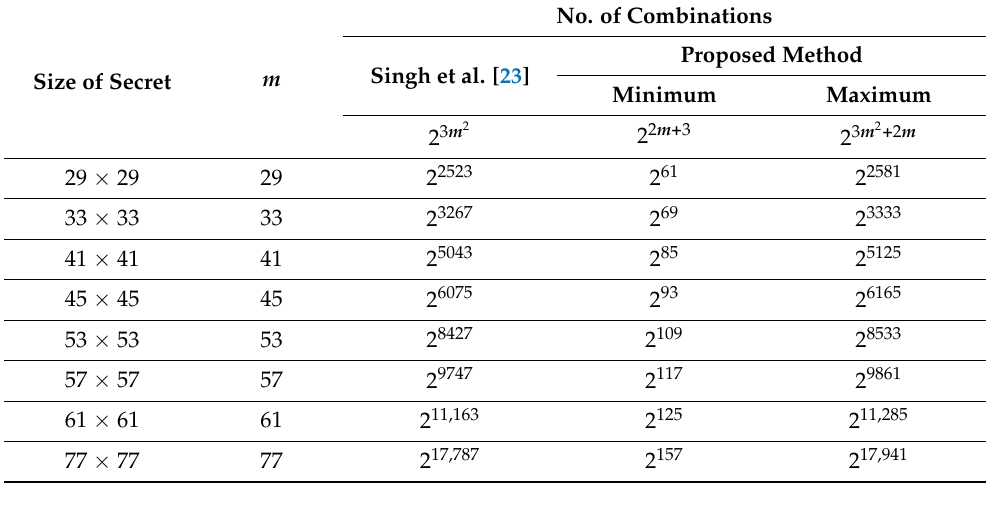
Table 5. No. of combinations for construction of shares.